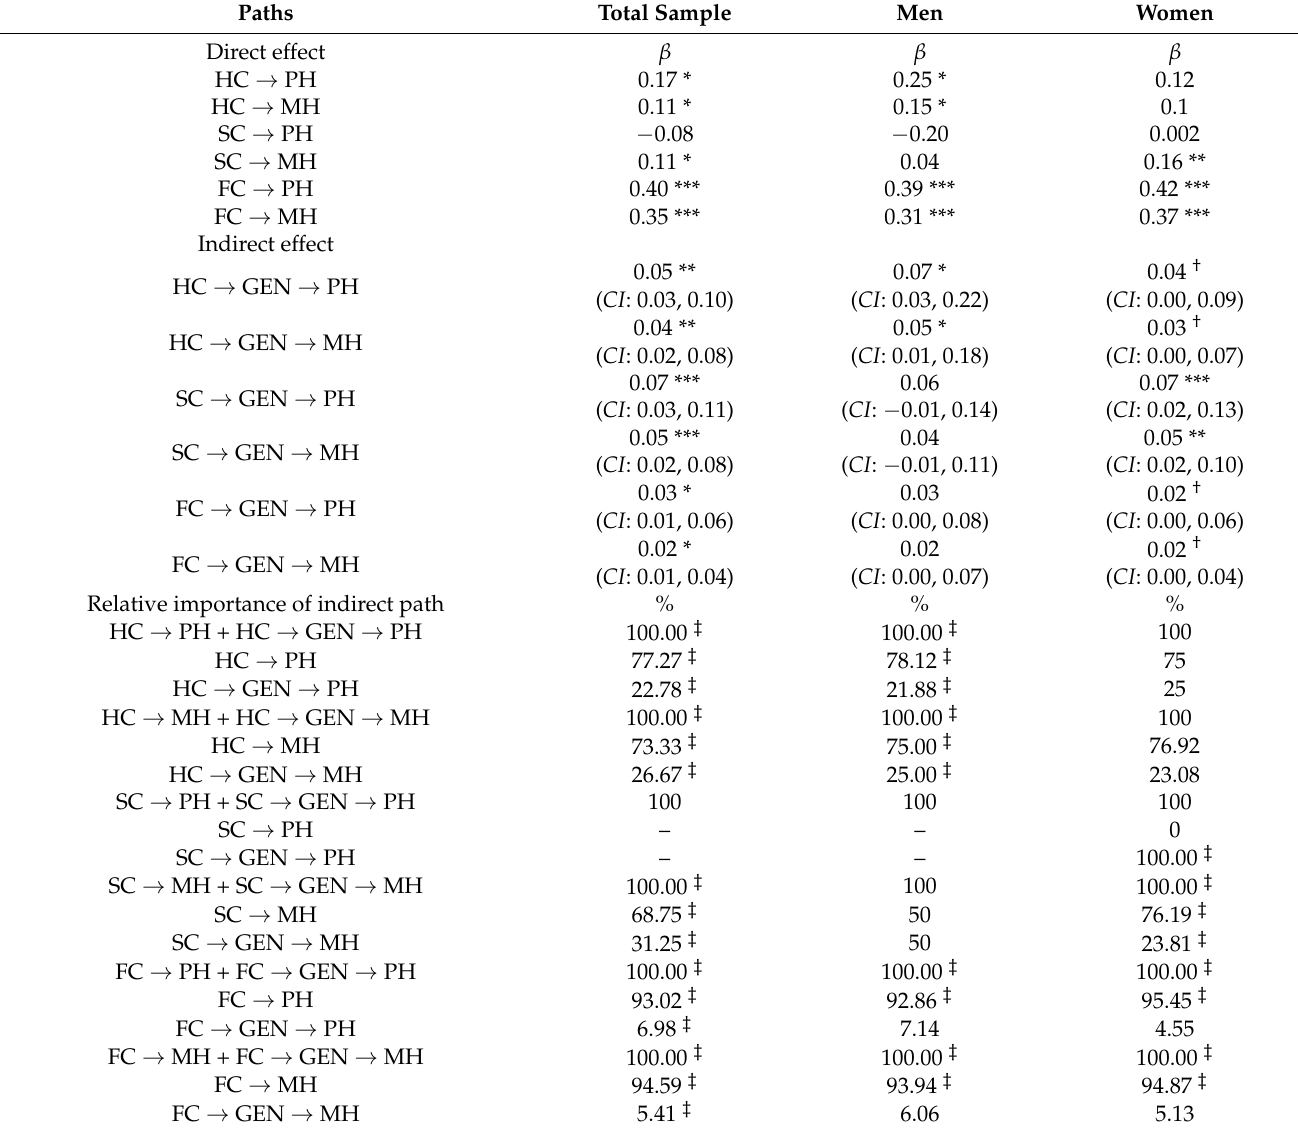
Table 2. Significance of standardized paths and relative importance of indirect